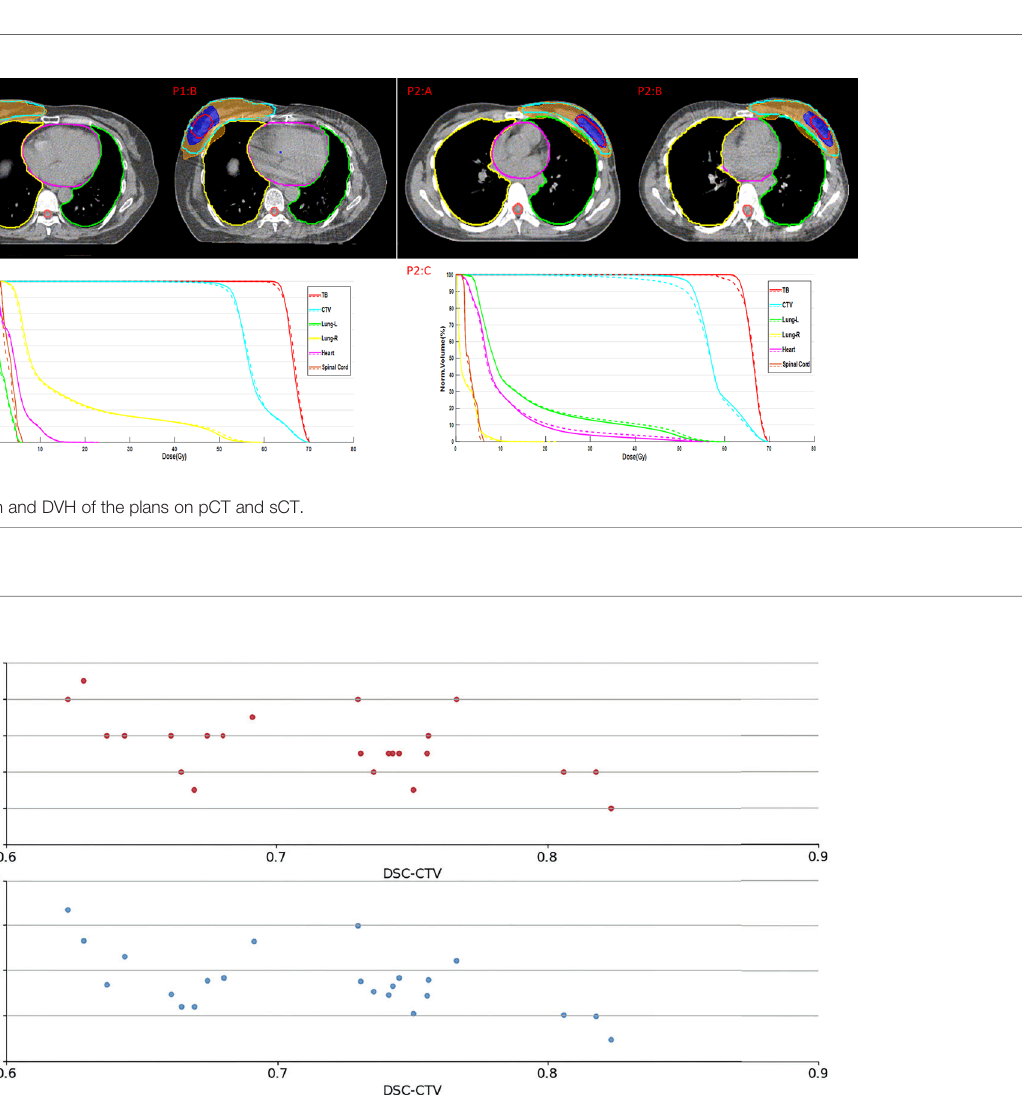
FIGURE 4 | (A) The relationship between DSC and D V95 of CTV; (B) the relationship between DSC and D D95 of CTV.